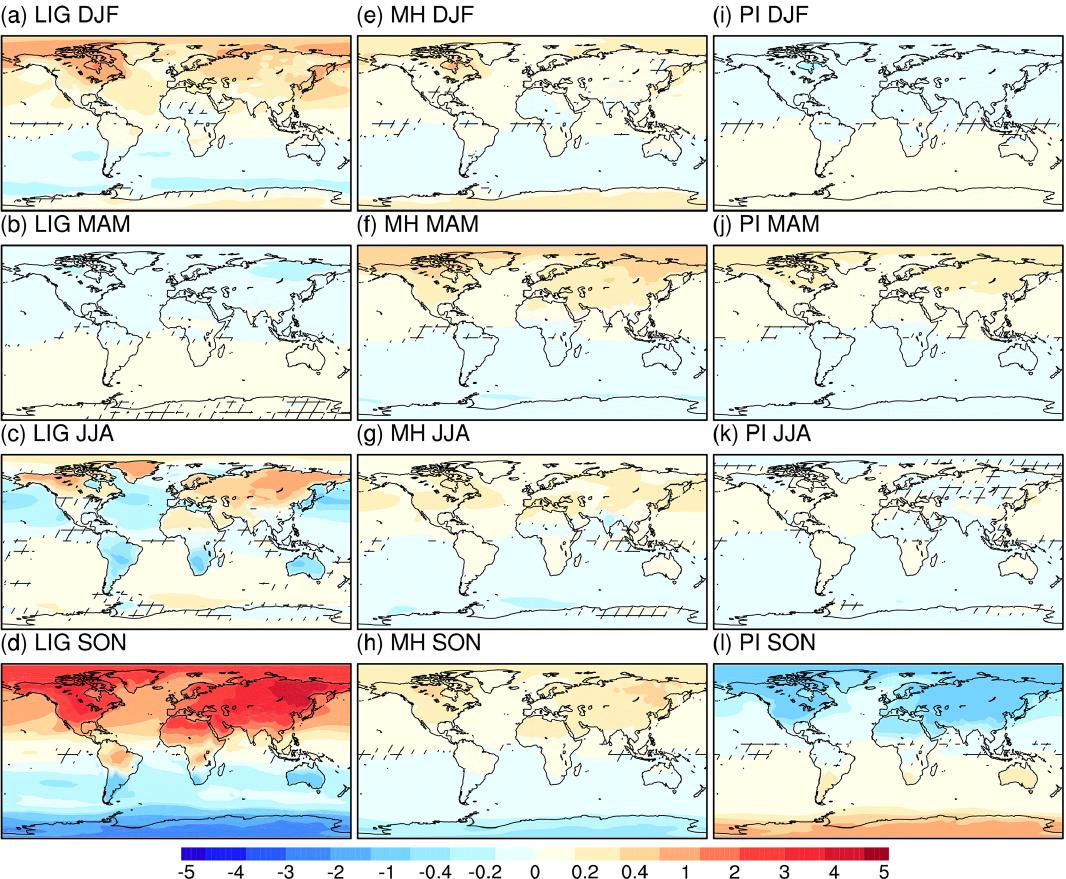
Figure 1. Ensemble anomalies of surface air temperature between angular means and classical means. The unmarked area indicates that at least seven models show the same sign. Units: K.